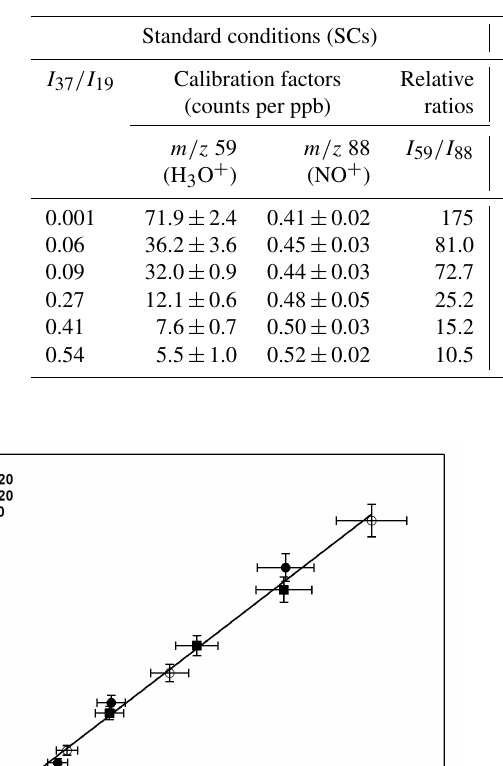
Table 4. Calibration factors and relative ratios determined for GL under SCs and CCs at the m/z 59 (C 2 H 3 O + using the H 3 O + and NO + precursor ions, respectively. The errors quoted correspond to the 2 σ precision of the fit to obtain the calibration factors.